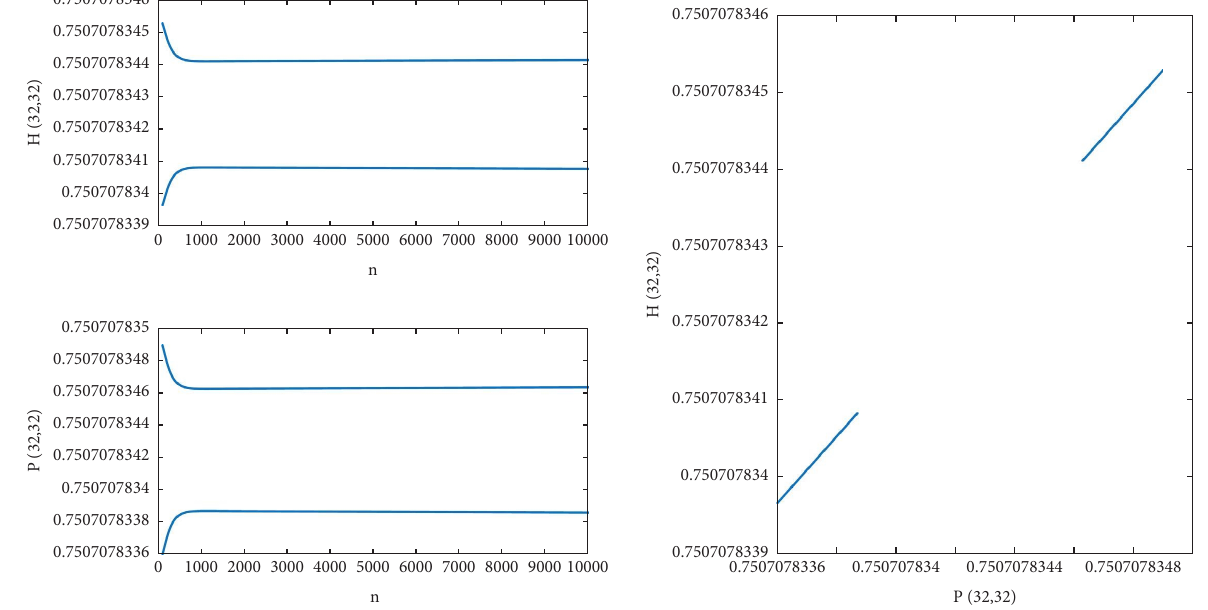
Figure 15: R � 2 ,k � 1, c � 0 . 8, σ ∗ � 0 . 278655, σ � 0 . 5, ( d which is consistent with the case of Corollary 3(3), a Flip bifurcation occurs, parasite and host populations exhibit